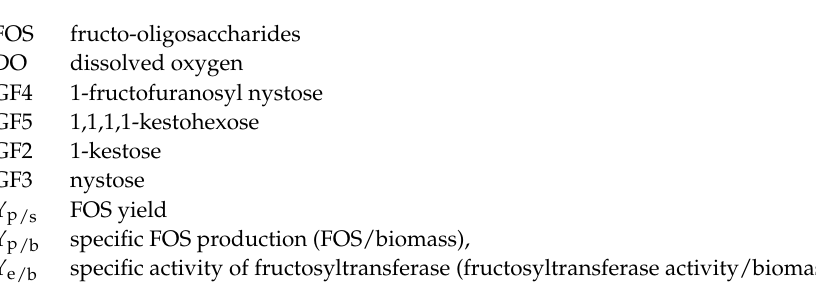
Supplementary Materials: The following are available online, Figure S1: Schematic diagram of the membrane system for FOS production in a membrane